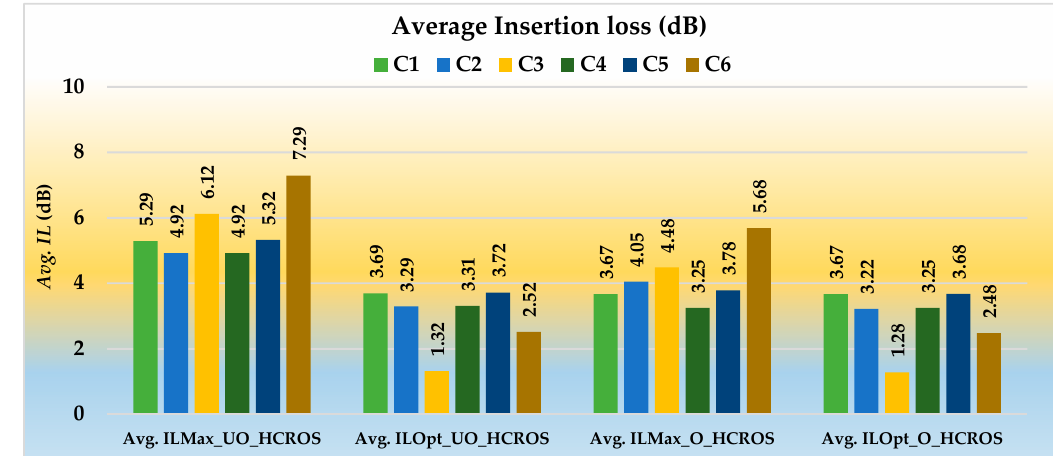
Electronics 2019 , 8 , x FOR PEER REVIEW